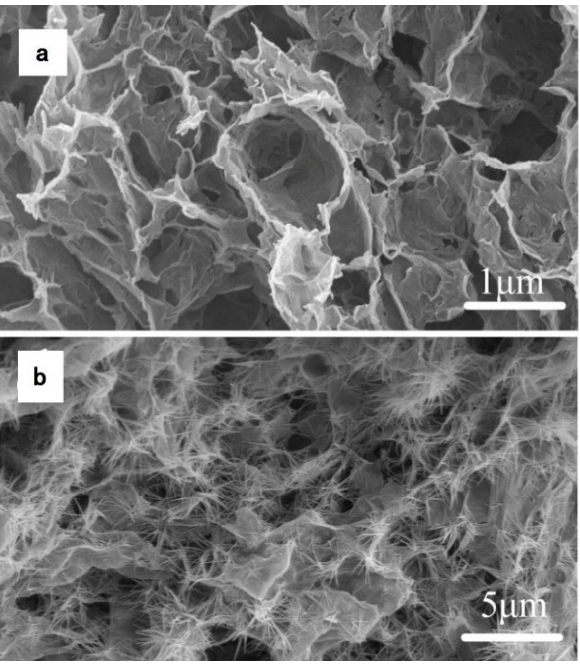
Figure 2. SEM images of ( a ) 3D graphene and ( b ) graphene/NiCo 2 O 4 . Reproduced with permission from [56]. Copyright 2022, Elsevier.